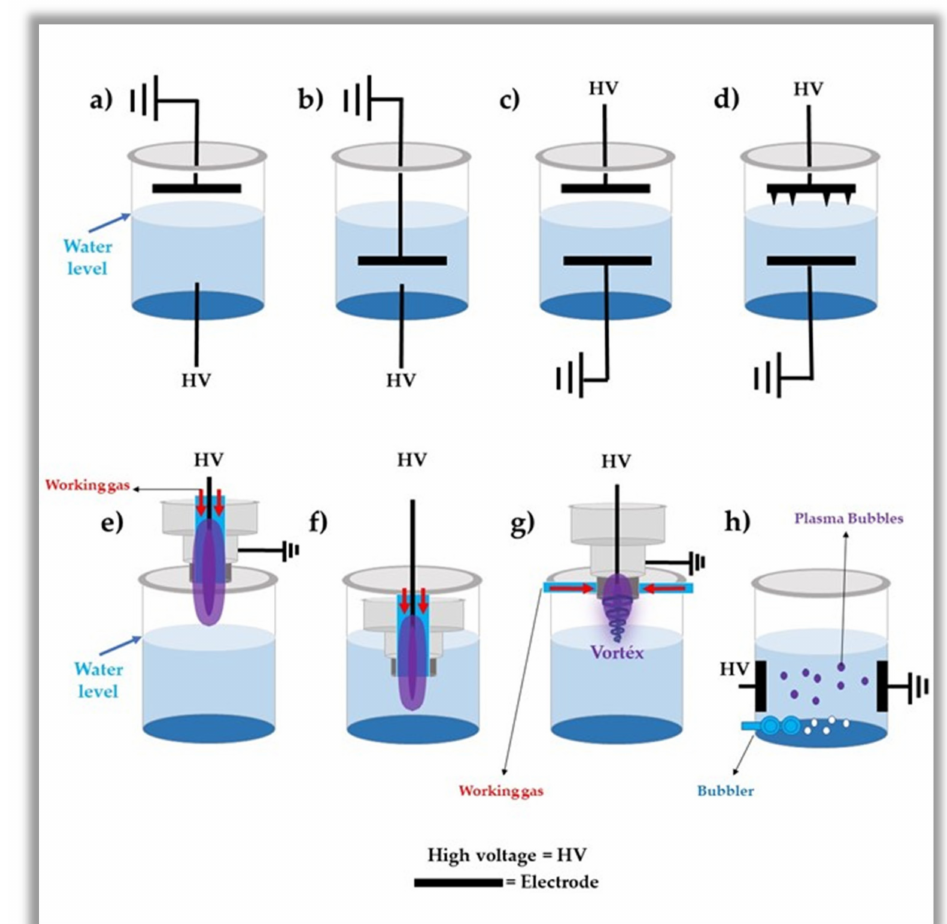
Figure 2. Schematic drawing of different discharges used for the preparation of plasma-activated water [47,74] ( a – c ) direct discharge into the water and ( d ) direct discharge into the water with multi- electrodes; ( e ) discharge in the gaseous phase onto the water surface; ( f ) discharge in the gaseous phase into the water; ( g ) discharge in the gas phase onto the water surface with plasma generated on forward vortex flow reactor (FVFR); ( h ) discharges in bubbles into the